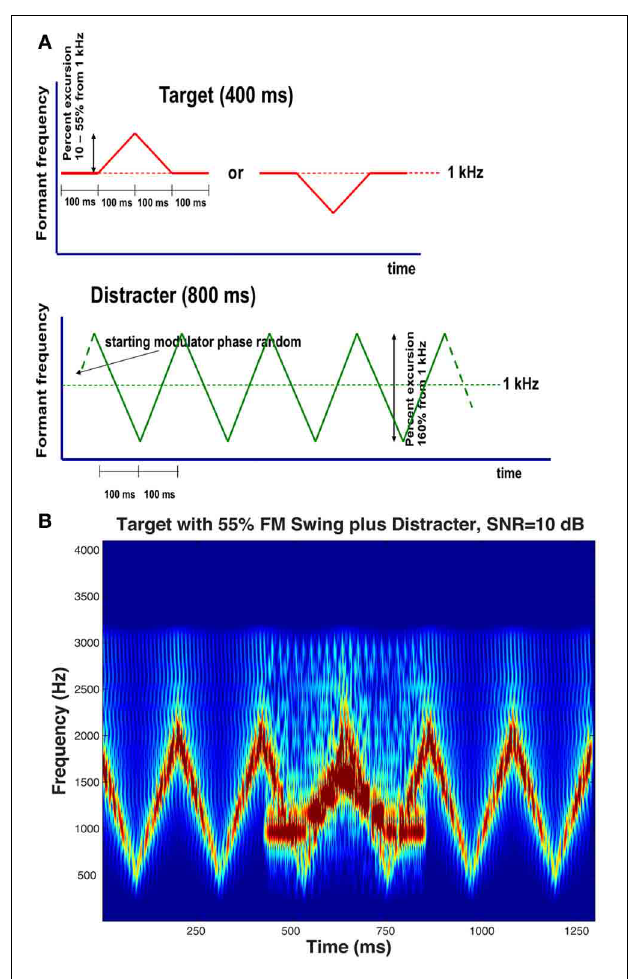
FIGURE 1 | (A) Schematic stimulus diagram, illustrating trajectory of the single formant’s peak in the target and in the distracter, frequency-modulated using a 5-Hz triangular wave. The upper traces illustrate the two target formant peak trajectory patterns that the listeners had to identify: a 100-ms ascending followed by a 100-ms descending trajectory or a 100-ms descending followed by a 100-ms ascending trajectory, both trajectories flanked by two 100-ms steady-state portions with a constant formant peak at 1kHz. The lower trace illustrates the trajectory of the distracter that consisted of an 800-ms pattern of repeating 100-ms ascending and descending trajectories between the 525 and 1800-Hz formant peak minimum and maximum that are equidistant from the 1-kHz center on a basilar membrane distance scale. The starting phase of the distracter’s modulating waveform varied randomly from trial to trial. All formant trajectories were linear on this distance scale. Both the target and the distracter were gated using a 25-ms cosinusoidal window to ensure that the onset and the offset of both were smooth. (B) Spectrogram of a trial. The target is an up-down transition with an FM excursion reaching 1550Hz, i.e., 55% higher than the resting 1-kHz formant frequency. The SNR of the example shown, 10dB, is larger than most conditions used in the